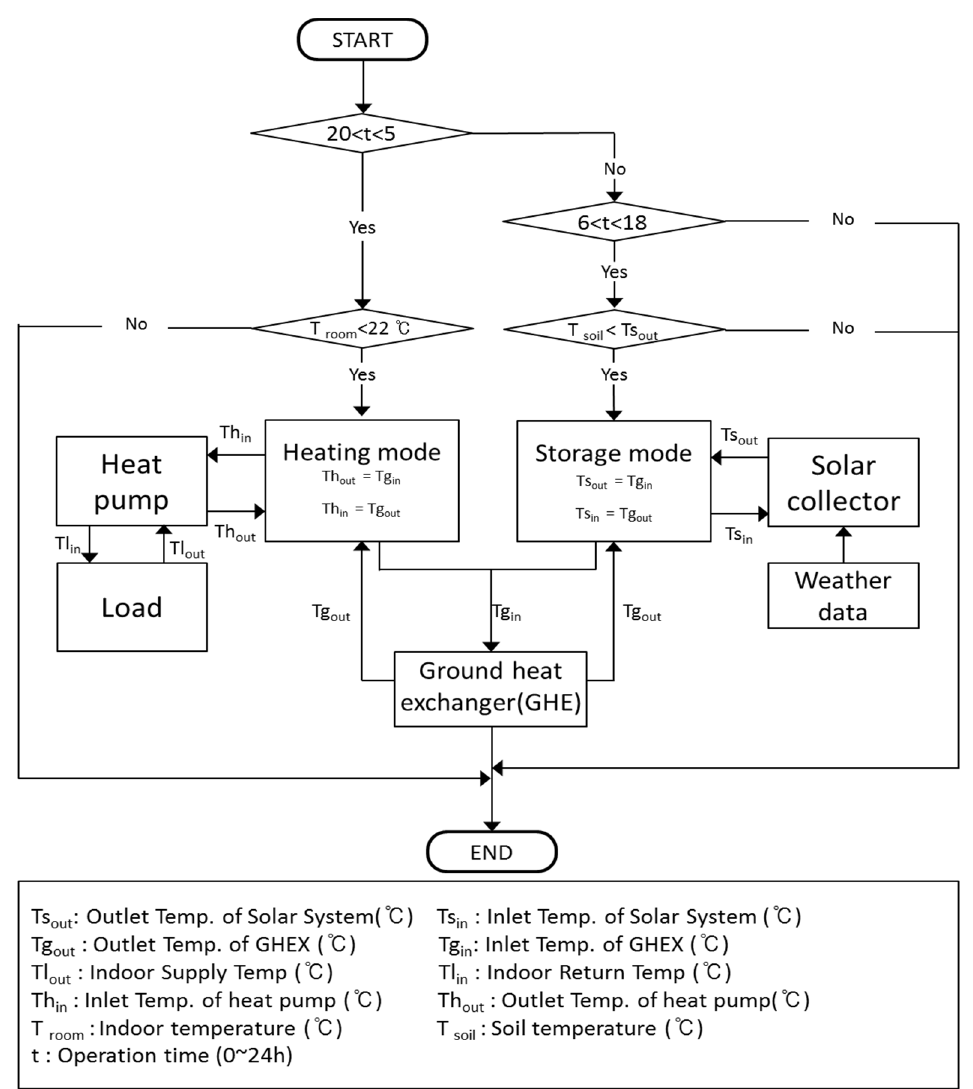
Figure 2. Flow chart of the running processes.